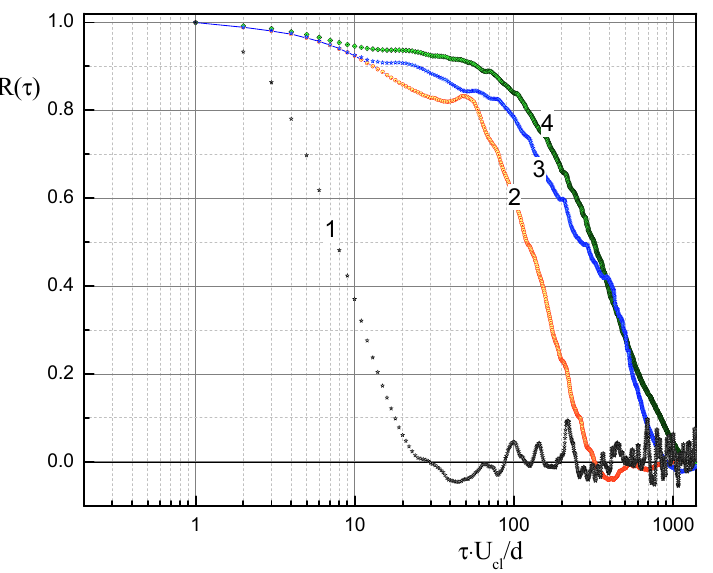
Figure 7. Autocorrelation function on the jet axis in the section x = 60 mm (CO 2 ): turbulent flow (1), and autocorrelation characteristics of single puffs (2–4).